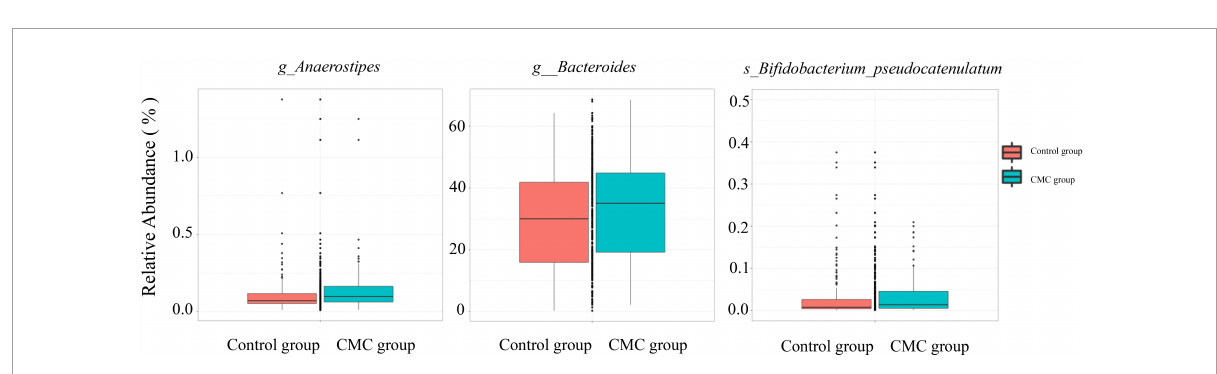
FIGURE4 Differences of taxa abundance present in subjects. Data were normalized via total sum scaling (TTS) method and are expressed as relative abundance. Some significantly CMC-associated GM are displayed (g, genus; s,